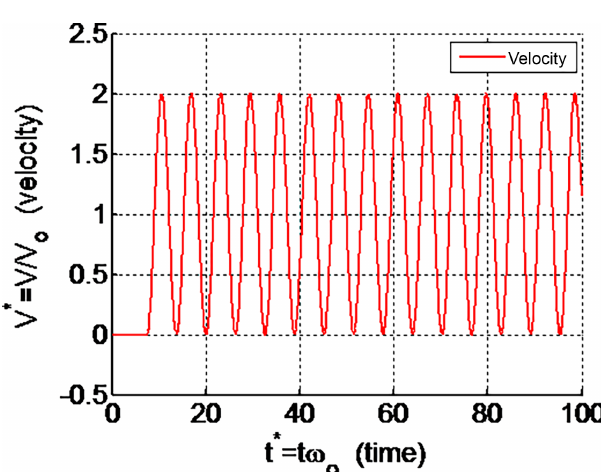
Figure 2. Block sliding with constant friction